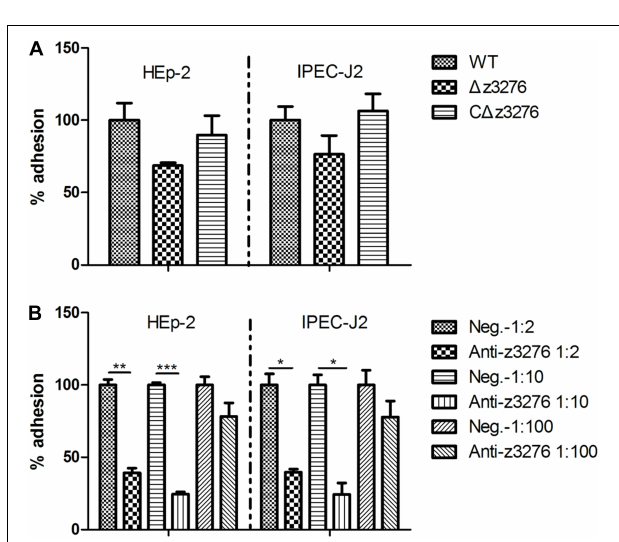
FIGURE 4 | Interaction of the WT and (cid:49) z3276 with HEp-2 and IPEC-J2 cells. (A) The (cid:49) z3276 mutant showed no change of adherence to either cell line compared with the parental strain. (B) Adherence of WT EHEC O157:H7 strain to HEp-2 and IPEC-J2 cells reduced after pre-incubation with blocking antibody (1:2 and 1:10 dilution). The WT strain adhesion index was assumed to be 100%. The results shown are the means + SEM of three independent experiments. ∗ Indicates significance at P < 0.05, ∗∗ and ∗∗∗ Indicate extreme significance at P < 0.01 and P < 0.001.